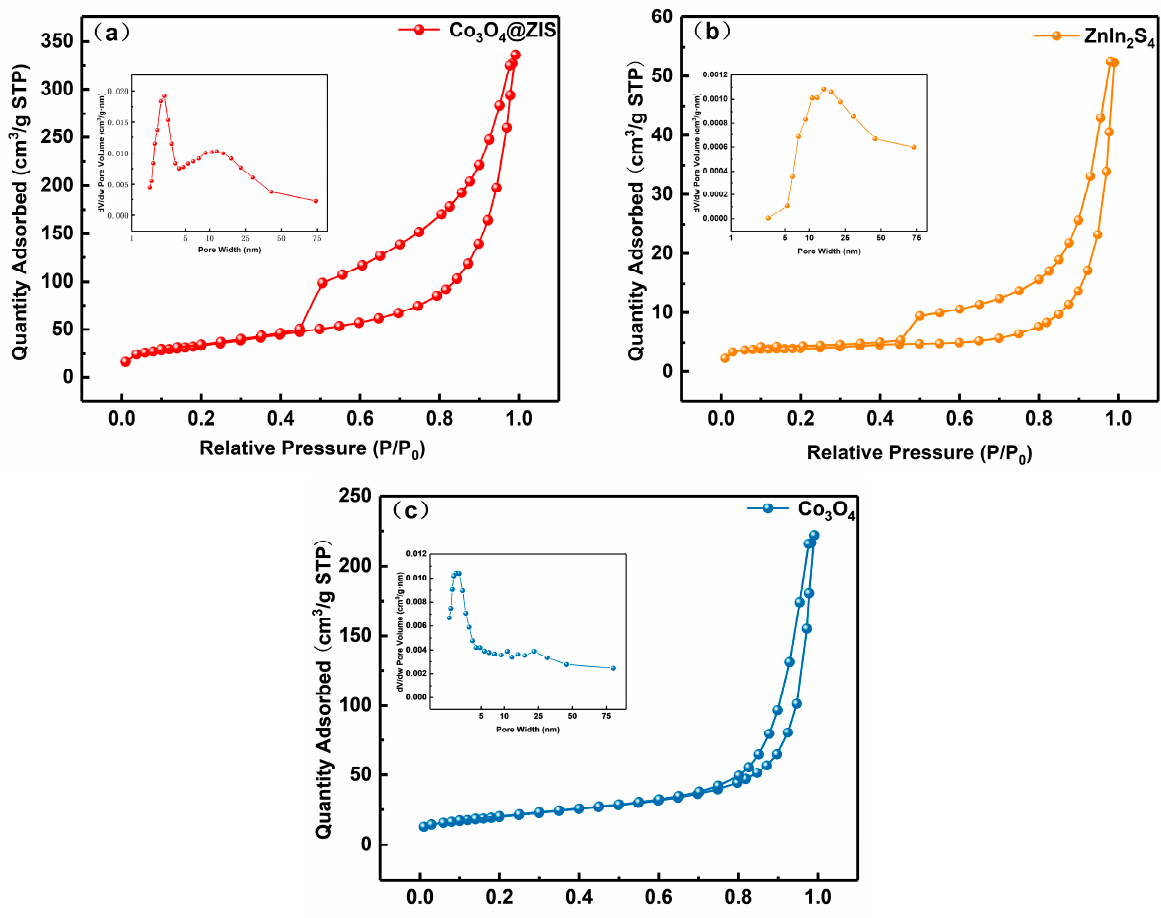
Figure 5. ( a ) General XPS images of Co 3 O 4 , Co 3 O 4 (20)@ZIS, and ZnIn 2 S 4 ; ( b ) Co 2p;.( c ) O 1s; ( d ) Zn 2p; ( e ) In 3d; ( f ) S 2p.